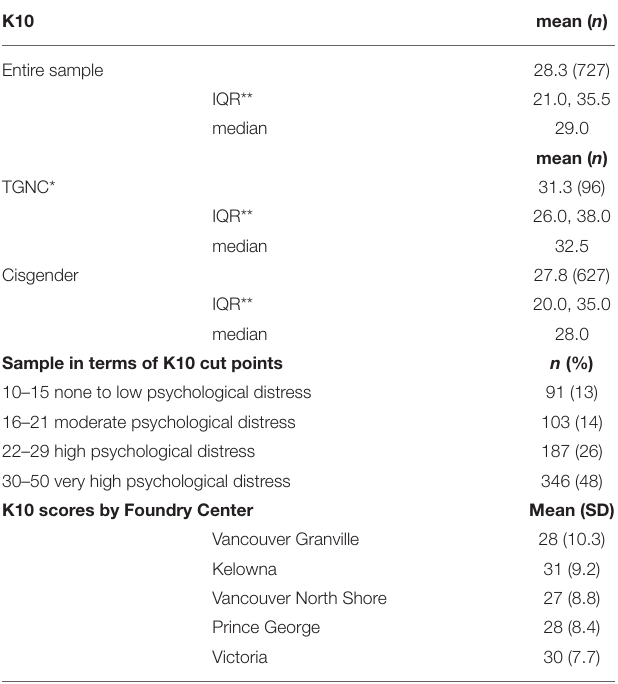
TABLE 2 | K10 scores by demographic